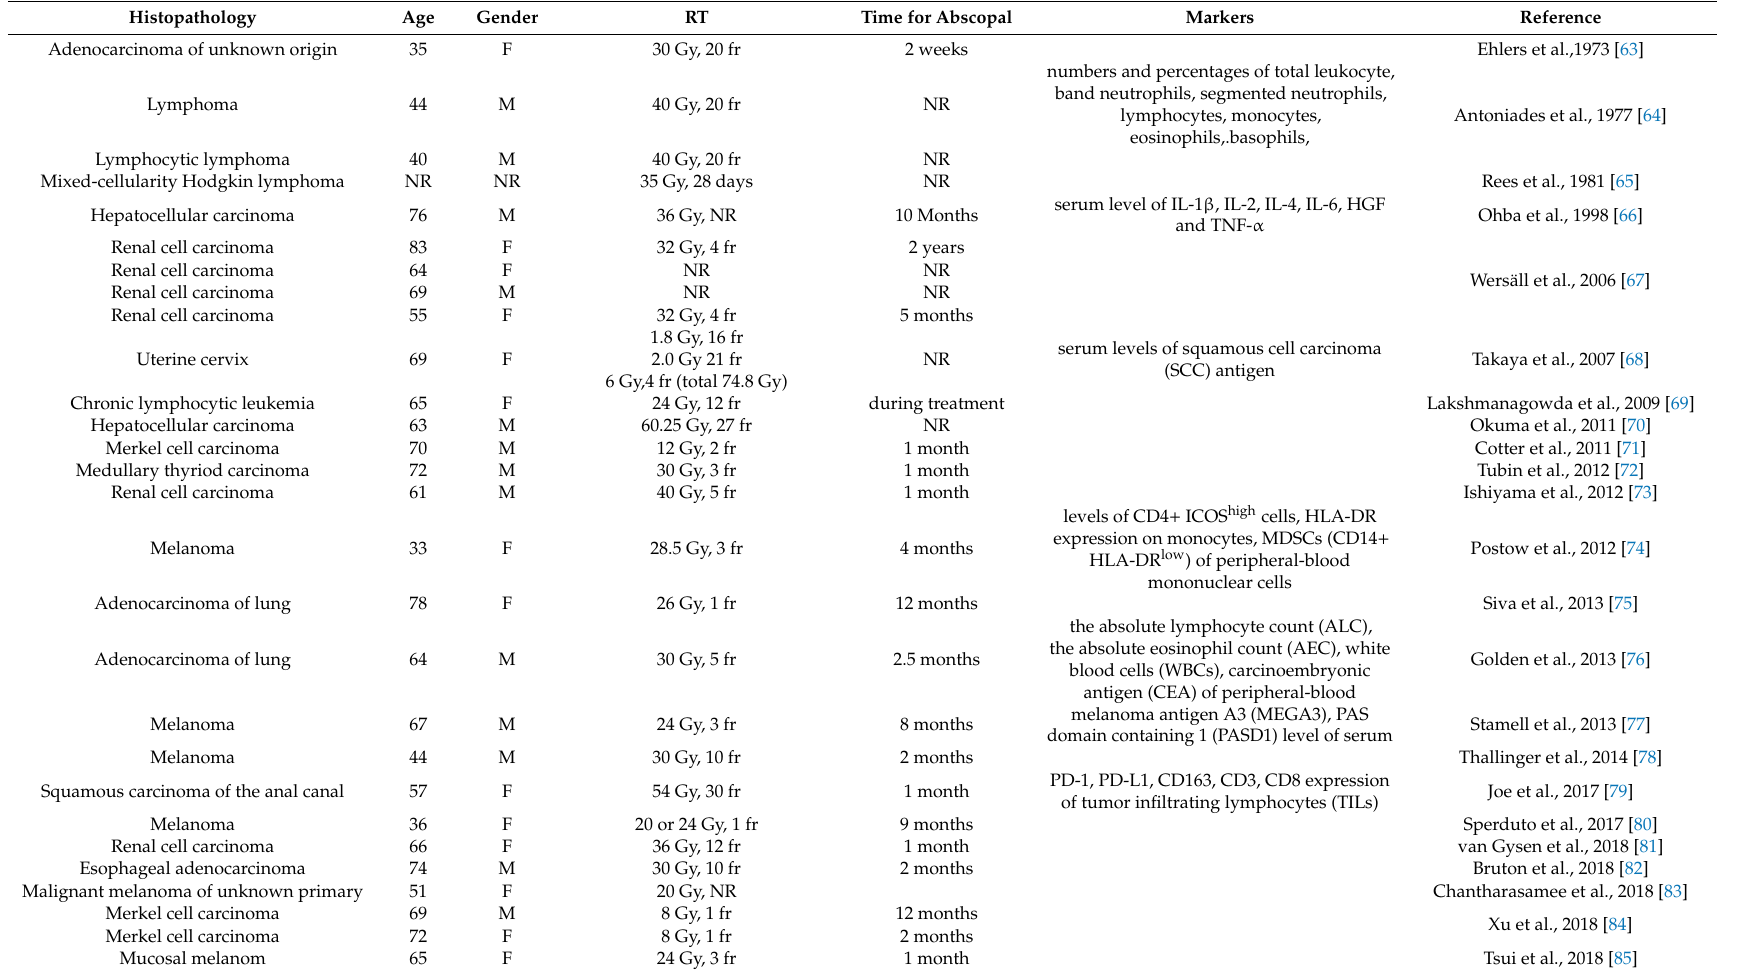
Table 1. Details of published case reports on abscopal e ff